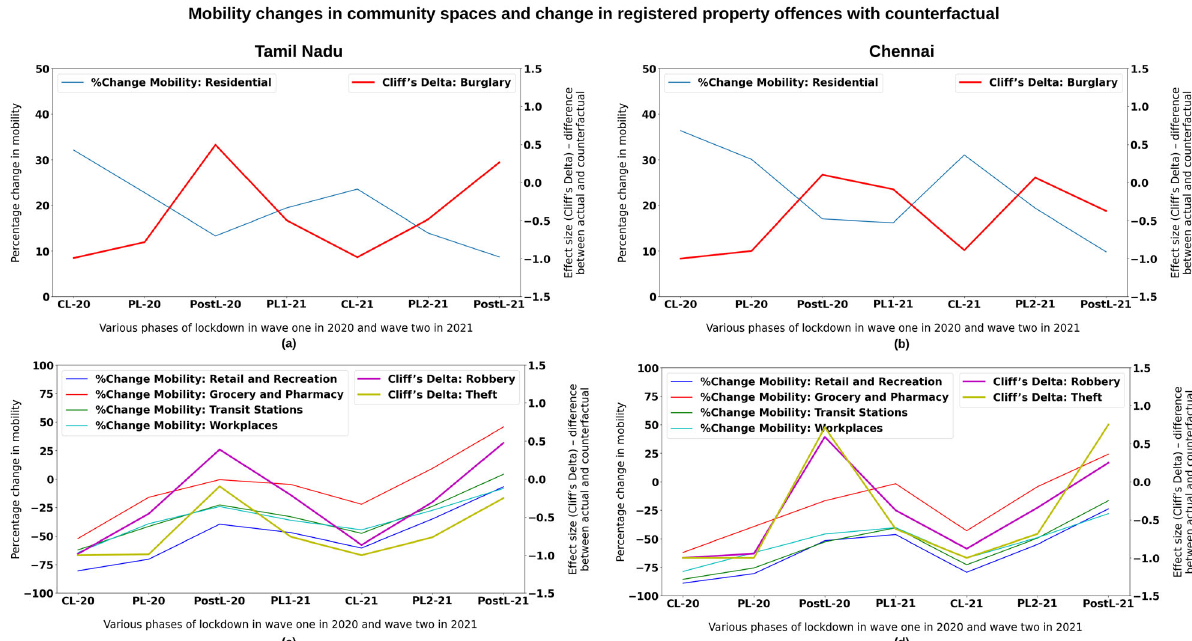
Fig. 6 Relationship between change in mobility and its impact on registered property offences. Association between the mean percentage change in mobility from baseline in different community spaces and change in actual registered property offences such as thefts, burglaries, and robberies with the counterfactual as expressed in effect size (Cliff ’ s Delta) across various phases of lockdown in both pandemic waves in Tamil Nadu (Left Panel — a and c ) and Chennai City (right panel — b and d ). The top panels are Residential vs. Burglary offences. The bottom panels are Other community space vs. Thefts and Robberies. The X -axis depicts the various stages of lockdown in discrete intervals (CL complete lockdown, PL partial lockdown, Post-L post-lockdown), and Y -axis shows the mean percentage change in mobility from baseline in different community